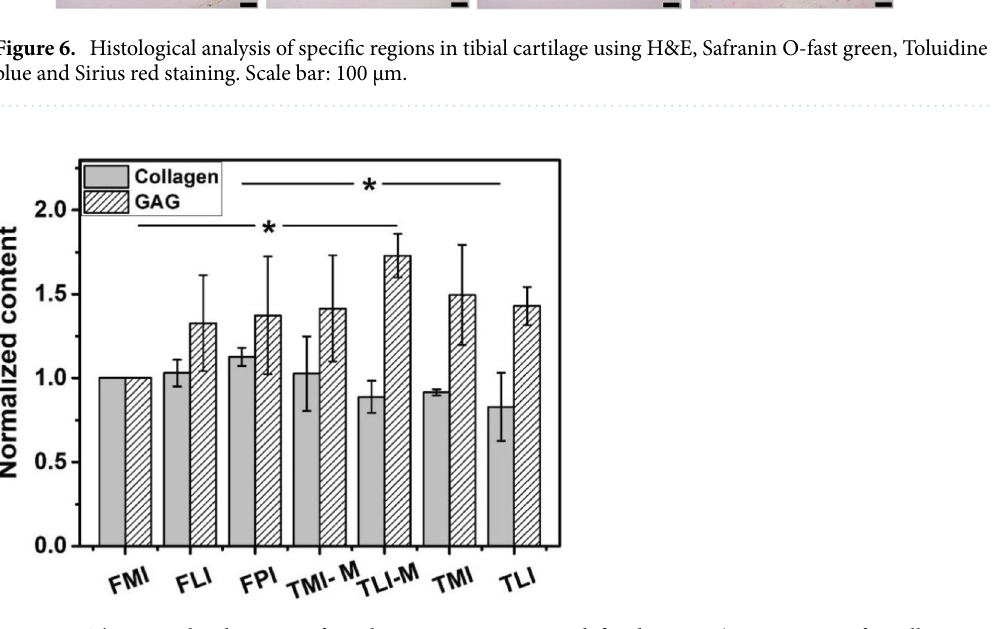
Figure 7. The normalized content of cartilage components in predefined regions (n = 3, p = 0.032 for collagen, p = 0.010 for